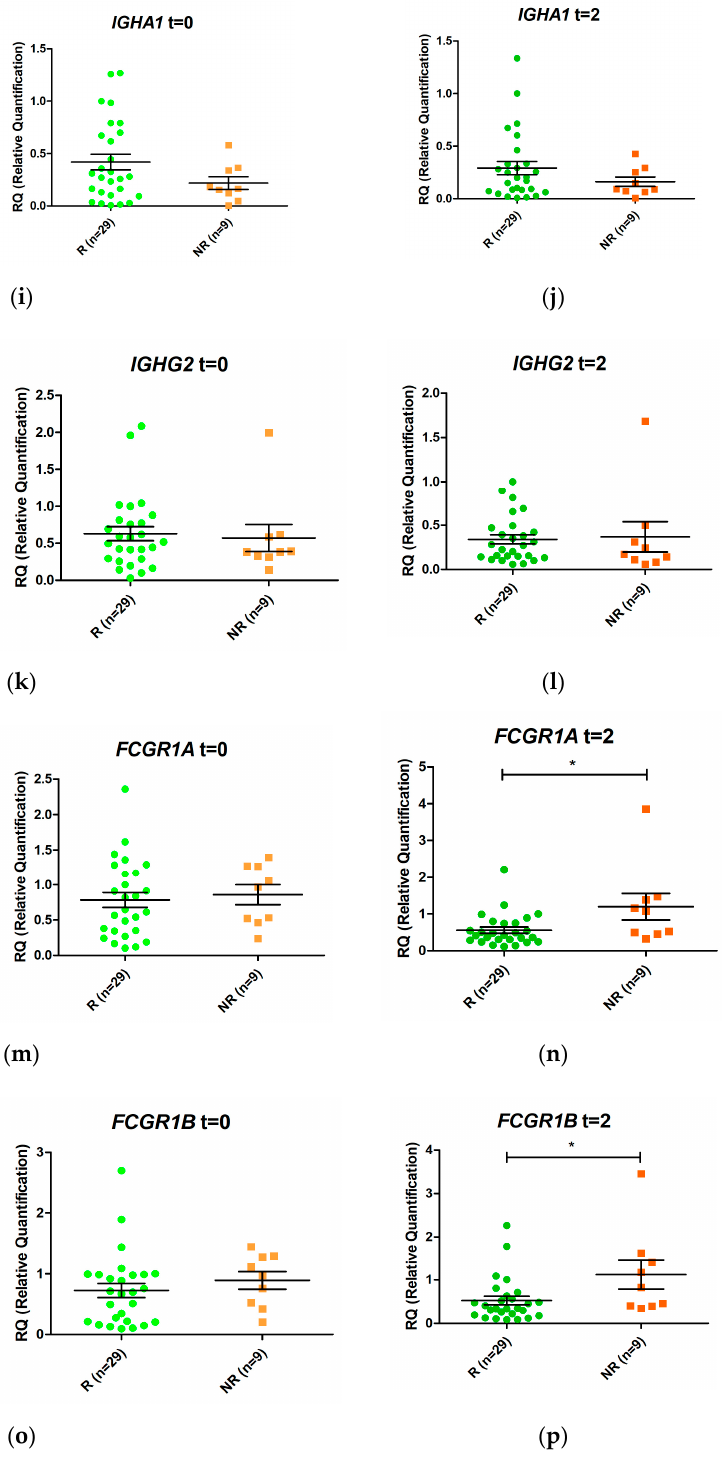
Figure 3. Relative expression levels of the genes GBP1 ( a , b ), GBP5 ( c , d ), GNLY ( e , f ), BATF2 ( g , h ), IGHA1 ( i , j ), IGHG2 ( k , l ), FCGR1A ( m , n ), and FCGR1B ( o , p ) in responders (R, green) and non-responders (NR, orange) at time 0 ( t = 0) and at two weeks ( t = 2) after initiation of anti-TNF therapy. Expression values were normalized to the ACTB and RPL4 genes. Values are expressed as mean (horizontal line) and standard error of the mean (SEM); n , sample size; * p value < 0.05 vs. control (unpaired t test).